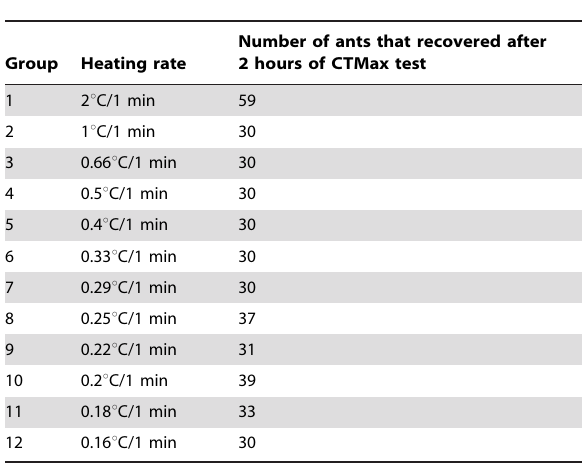
Table 1. Heating rates treatments and sample